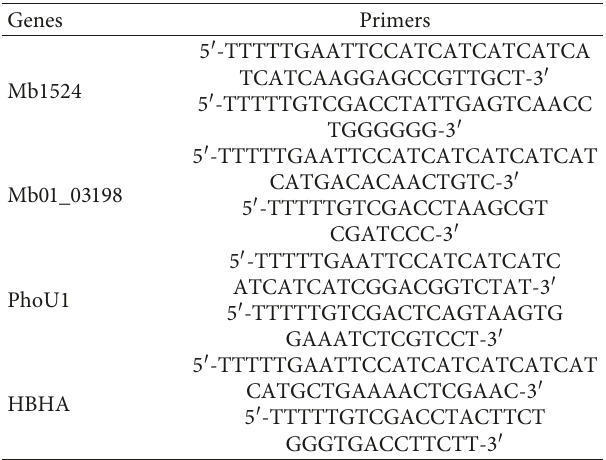
Table 1: Primers used for construction of M. smegmatis clones overexpressing M. bovis BCG surface antigens in the pMV261 vector. His-tag was incorporated in the